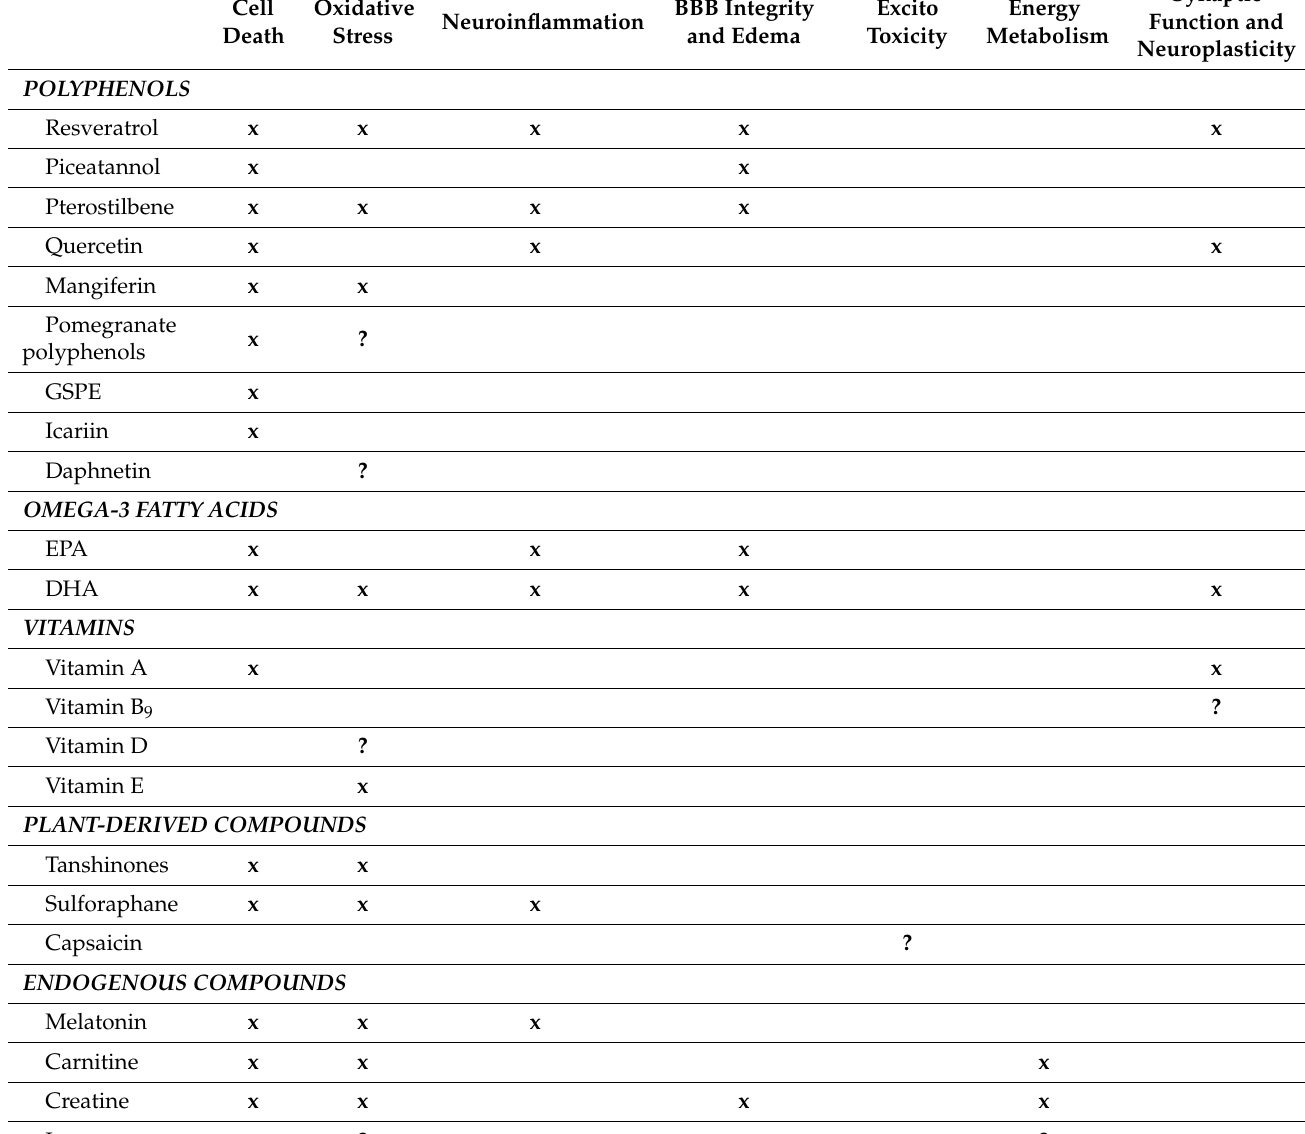
Table 2. Possible neuroprotective mechanisms of natural products associated with benefits against neonatal HI damage.